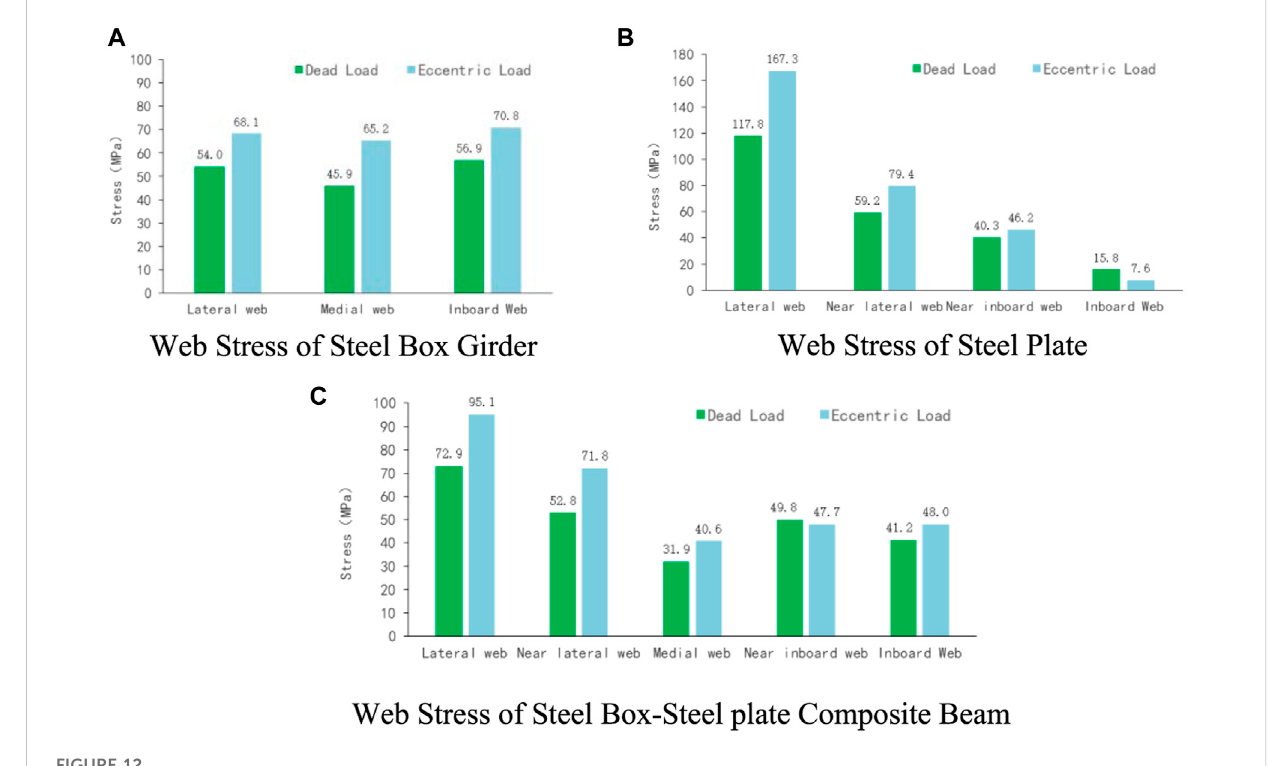
FIGURE 12 Comparison of web stress of curved girder.